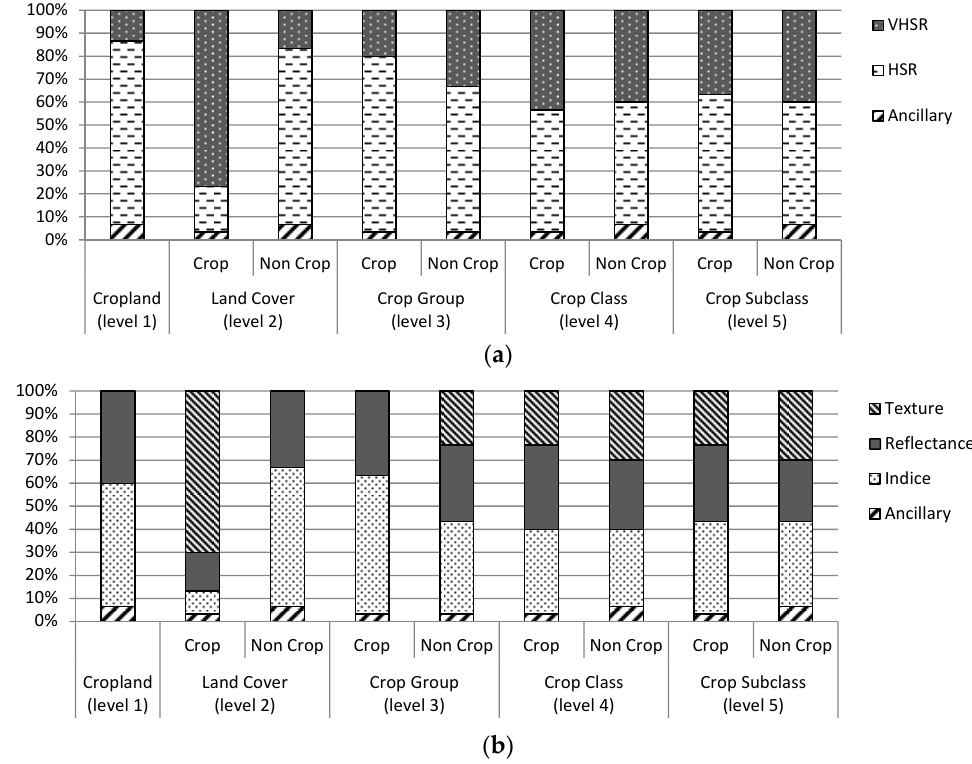
Figure 6. Proportions of different sources— high spatial resolution imagery (HSR), very high spatial resolution imagery (VHSR), and ancillary—( a ) and types—reflectances, spectral indices, textures, and ancillary—( b ) of variables among the 30 most important variables (ranked by MDA measure) for each level of the JECAM (Joint Experiment for Crop Assessment and Monitoring) nomenclature.